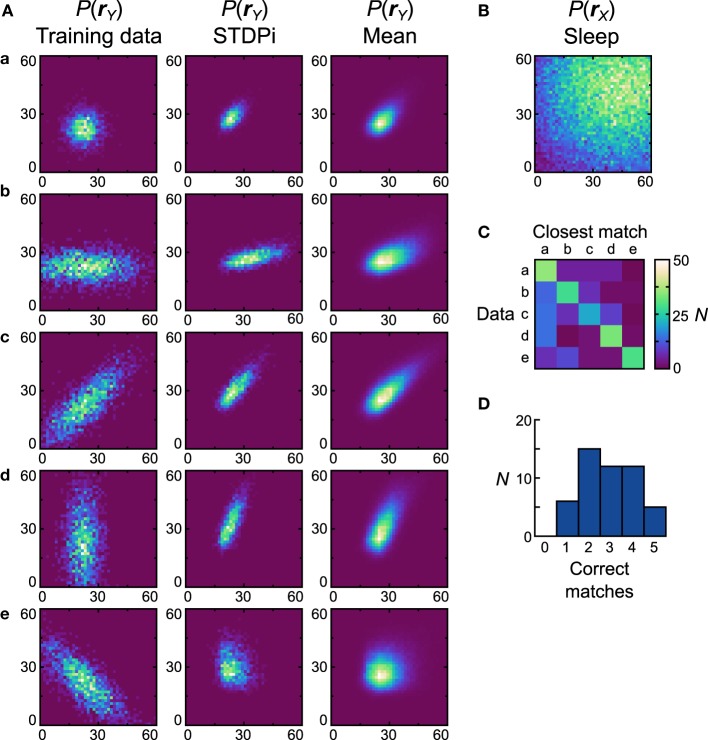
Performance of the neuronal network implementation of the Helmholtz Machine with the STDPi rule and unimodal data sets. See Figure 7 for explanation of the panels. The parameters for the STDPi kernels are, τ1 = 50 ms, τ2 = 20 ms.